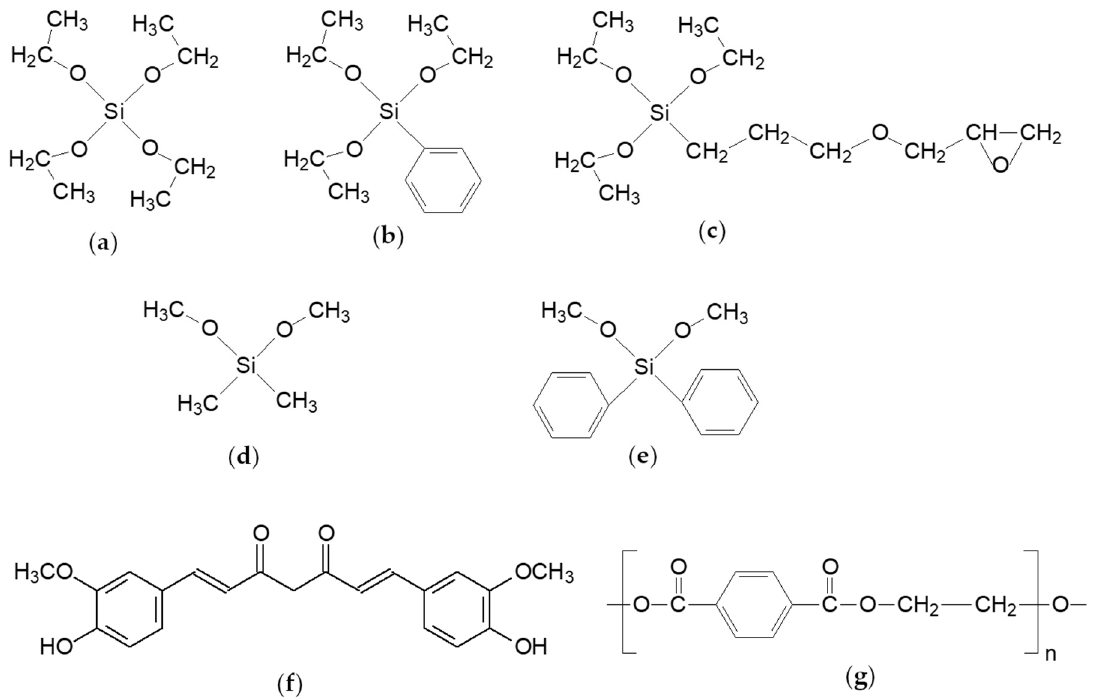
Figure 1. Raw materials used to obtain coated textile fibers: ( a )—tetraethoxylortosilicate, ( b )—phenyltriethoxysilane, ( c )—3-glycidoxypropyltriethoxysilane, ( d )—dimethoxydimethylsilane, ( e )—dimethoxydiphenylsilane, ( f )—curcumin, ( g )—polyester